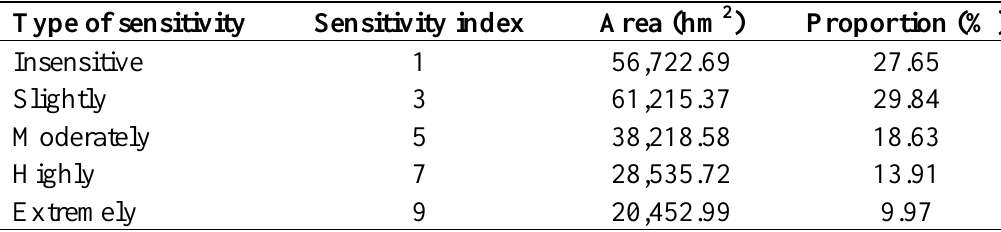
Table 2. Soil-erosion sensitivity evaluation results for Yicheng